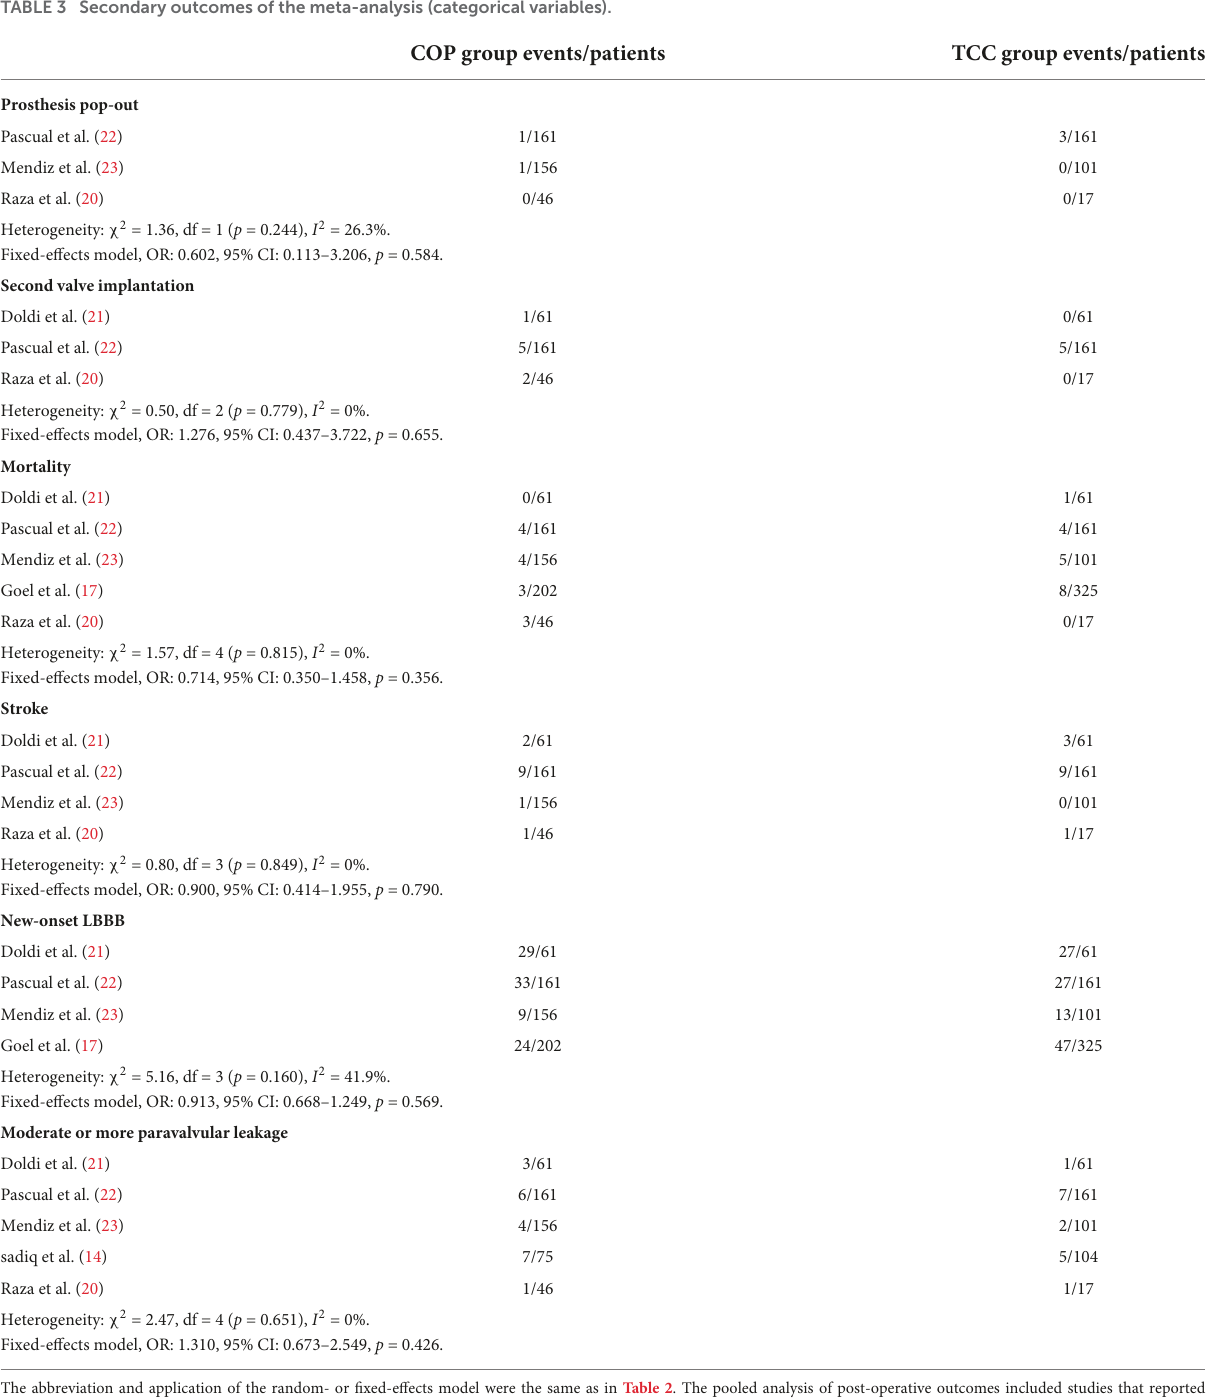
TABLE 3 Secondary outcomes of the meta-analysis (categorical variables). COP group events/patients TCC group